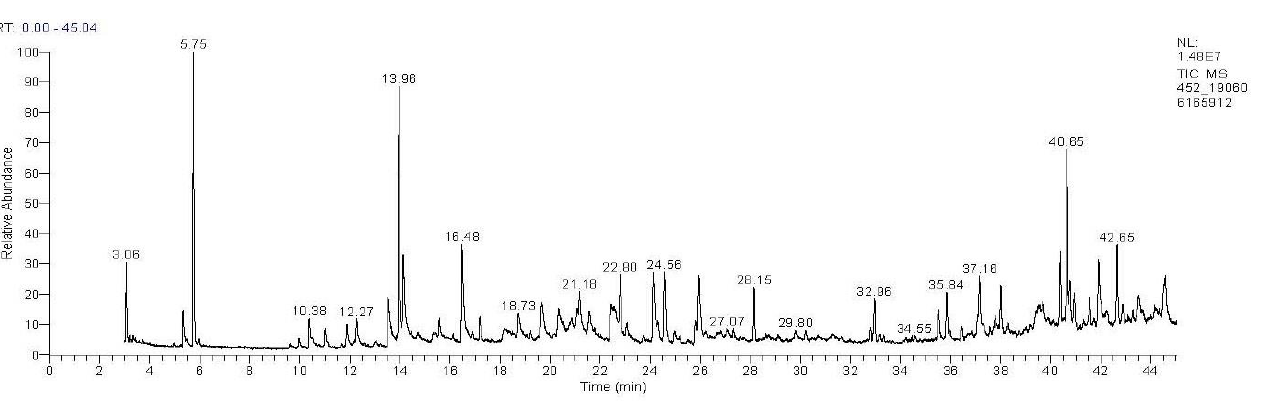
Figure 1. Chromatographic profile of the GC/MS analysis of C. sativus EO studied. Table 2. Chemical profile (GC/MS) of the essential oil of C. sativus .